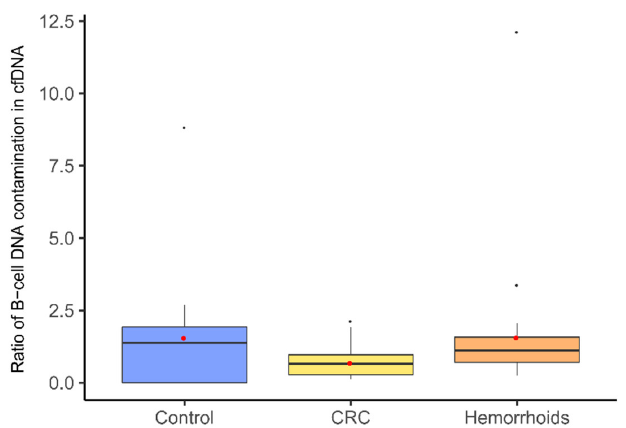
Figure 4. The ratio of B-cell DNA measured in cell-free DNA isolated from the serum of different groups of patients. Ratio ranges are represented with box plots—red dots represent average values in each group (healthy controls 1.55%, colorectal cancer patients 0.69%, and hemorrhoid patients 1.57%). One-way ANOVA did not show any statistically significant difference between groups. Control—healthy controls, CRC—colorectal cancer patients.